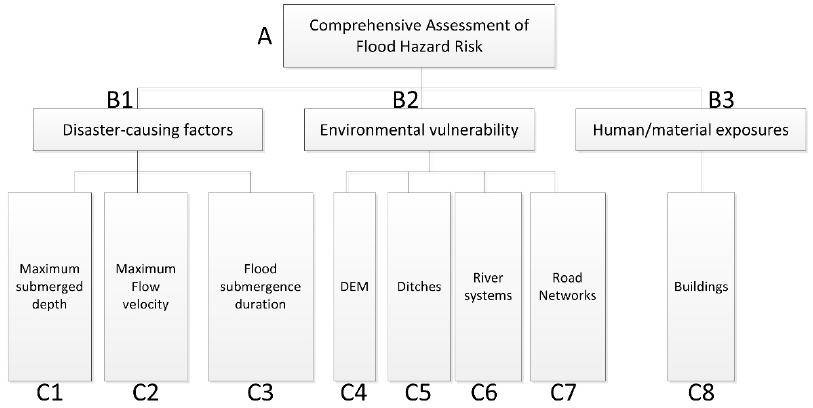
Figure 7. Selection tree of comprehensive flood hazard risk (FHR) indicators.